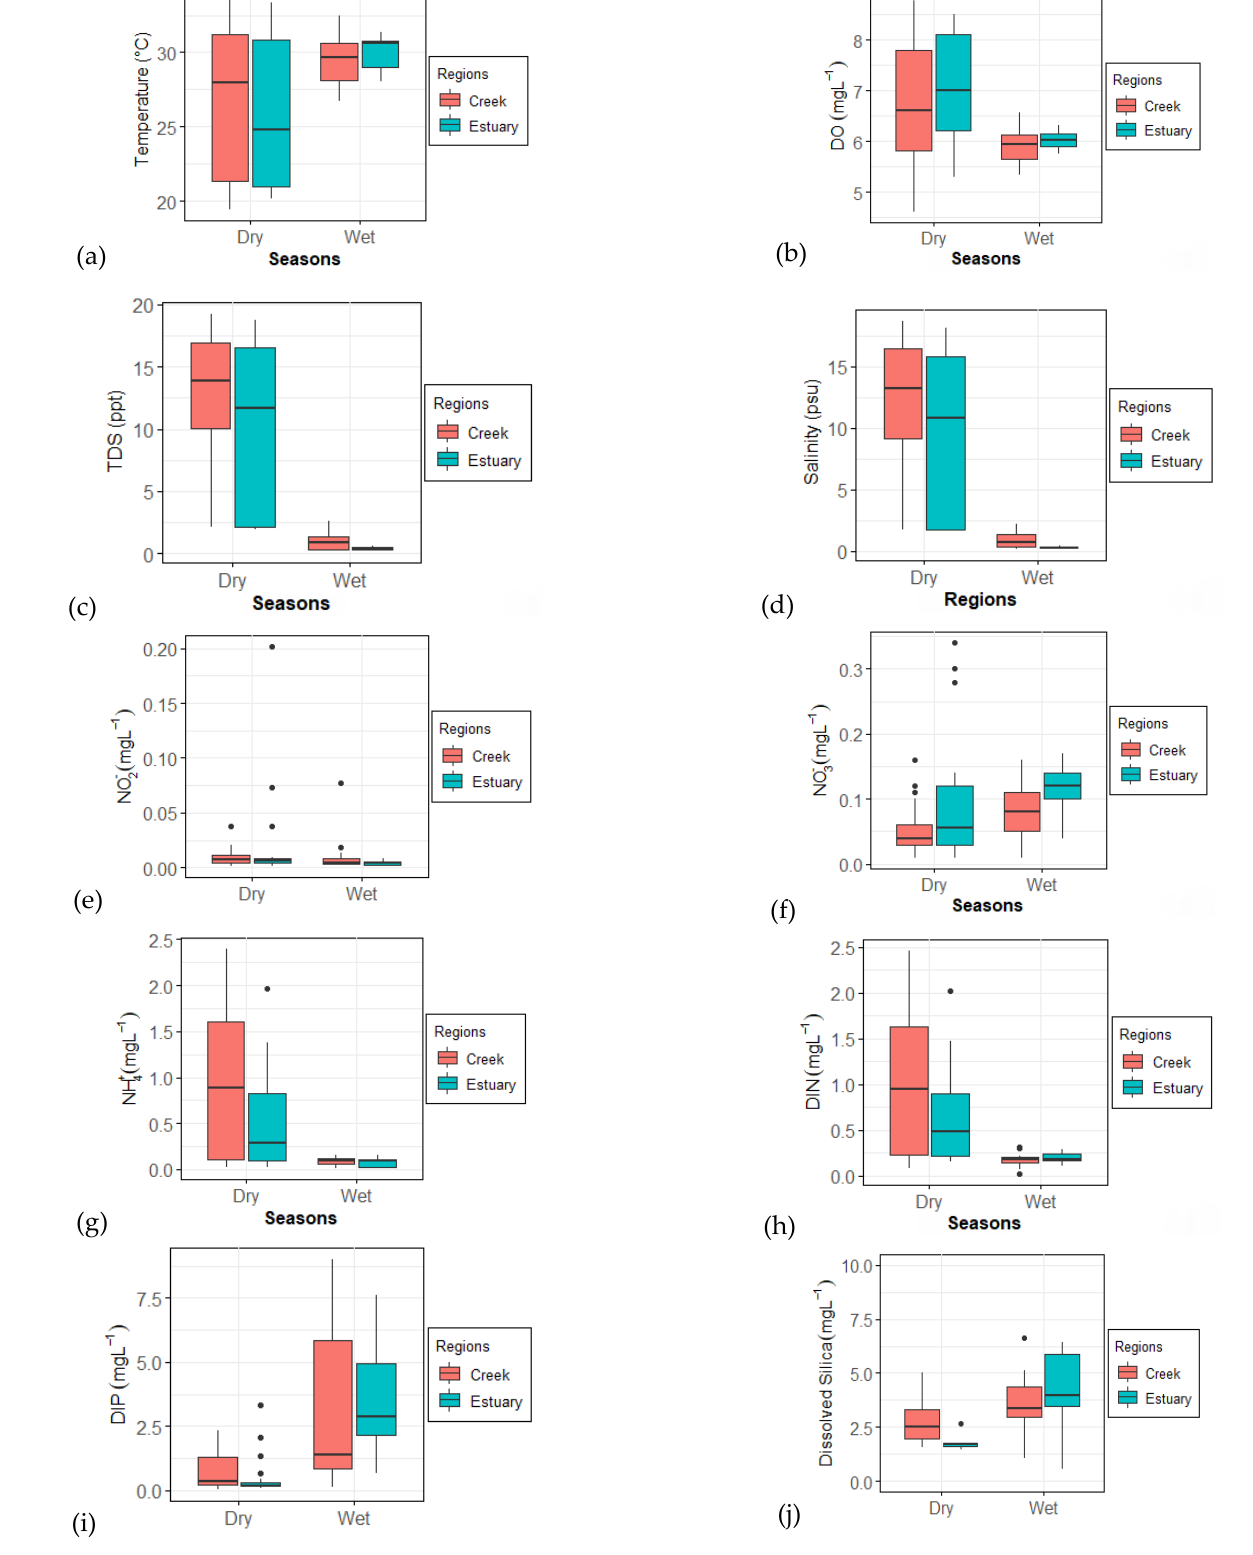
Figure 2. Spatial and temporal variation of major hydrochemical parameters. ( a ) Temperature, ( b ) Dissolved oxygen, ( c ) Total dissolved solids, ( d ) Salinity, ( e ) Nitrite ( f ) Nitrate, ( g ) Ammonium, ( h ) Dissolved inorganic nitrogen, ( i ) Dissolved inorganic phosphorus, ( j ) Dissolved silica. Dissolved oxygen (DO) at the study locations ranged from 4.62 to 8.77 mg/L with an average of 6.54 mg/L. DO concentrations were found to be higher during the dry season (6.77 ± 0.53 mg/L) ( p < 0.057) (Table 1), than during the wet season (5.96 ± 0.13 mg/L) in the tidal mangrove creeks and the PRE due to higher temperatures being observed during the wet season and lower temperatures being observed during the dry season (Tables 2 and 3). The DO concentration was higher in the PRE at 7.1 mg/L during the dry season and 6.03 mg/L during the wet season than in the tidal mangrove creeks at 6.65 mg/L dur- ing the dry season and 5.92 mg/L during the wet season (Figure 2b). The pH value was higher during the wet season (7.75 ± 0.16) compared to the dry season (7.66 ± 0.14) (Tables 2 and 3). During the dry season, pH values were, respectively, 7.5 and 7.6 in the PRE and mangrove creeks. On the other hand, during the wet season, pH values were 7.8 and 7.7 in the PRE and mangrove creeks, respectively.